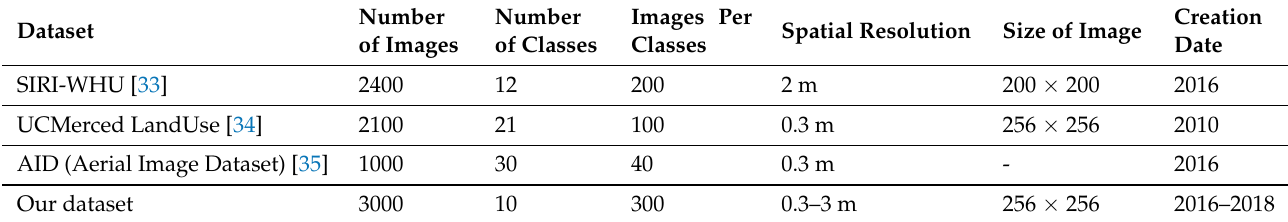
Table 2. Comparison table of the four different satellite image